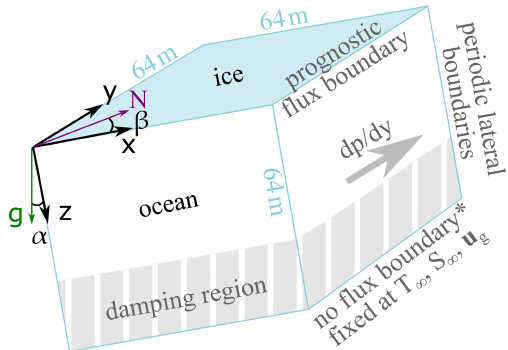
Figure 1. Schematic of the simulated ocean domain with back- ground pressure gradient d p/ d y . The purple arrow is oriented north, and the green arrow is aligned with gravitational acceleration. The ∗ signifies that the bottom boundary condition is Dirichlet, but there is also no flux as a result of